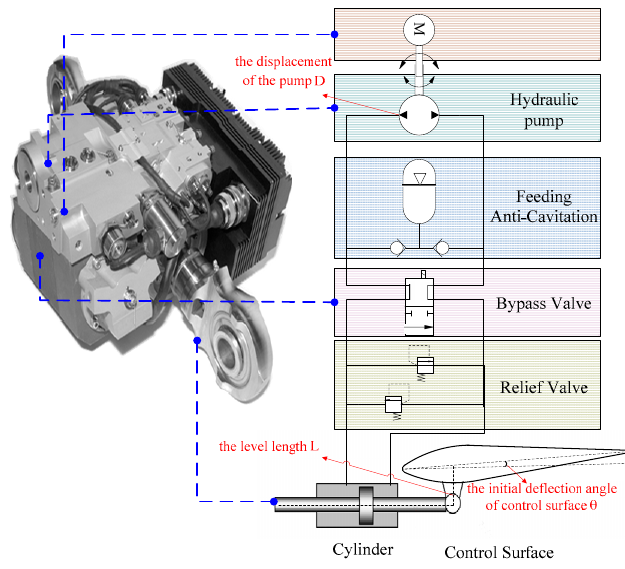
Figure 2. The structure of the EHA system.